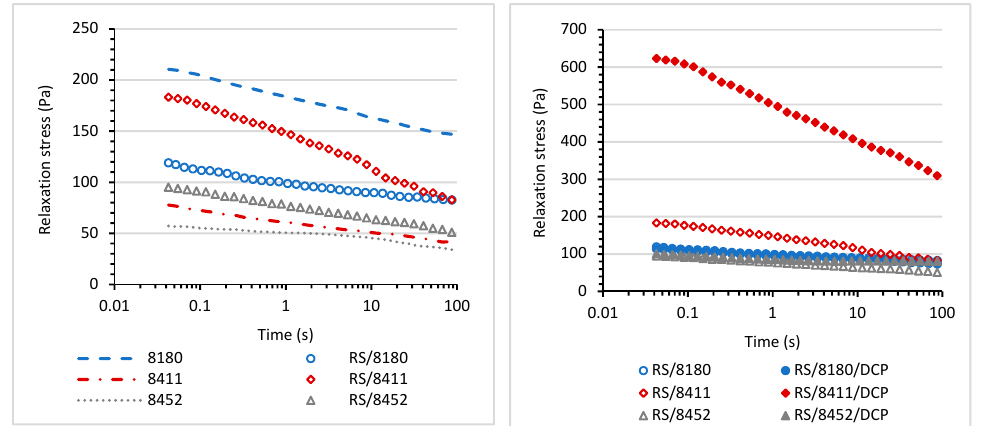
Figure 7. Relaxation stress as a function of the logarithm of time.